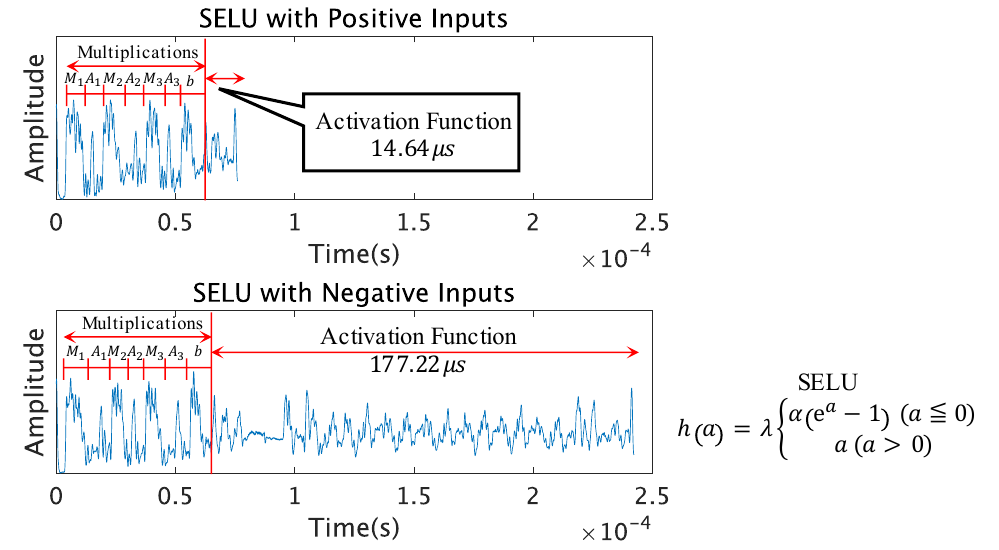
Figure 8. Extracted Pattern Measurements of the SELU Function.